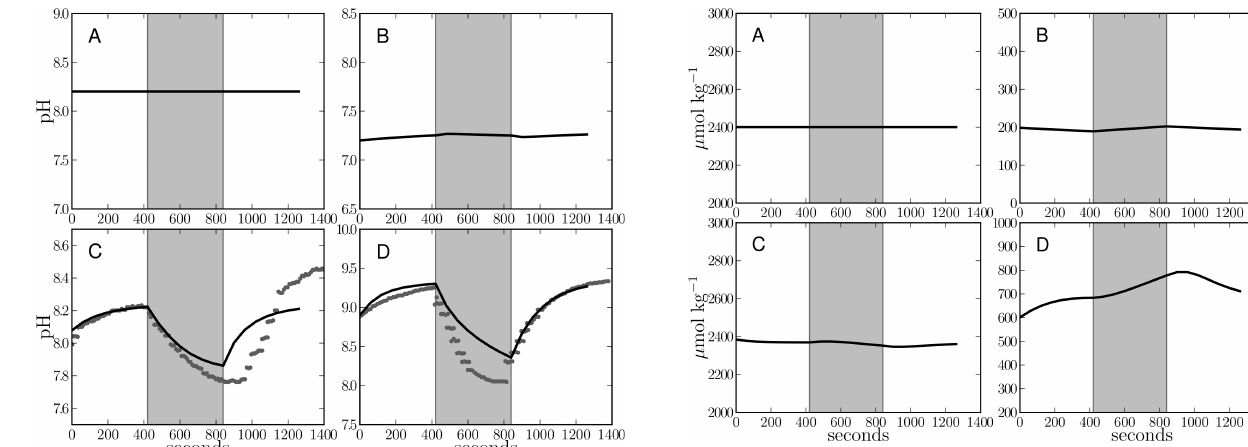
Fig. 4. Simulated pH over time (black lines) in the four model com- partments ( A =seawater; B =tissue; C =coelenteron; D =calcifying fluid). The observations (grey dots) are from the microsensor stud- ies of Al Horani et al. (2003). Light periods range from 0 to 420s and from 840 to 1260s. The dark period is between 420 and 840s.